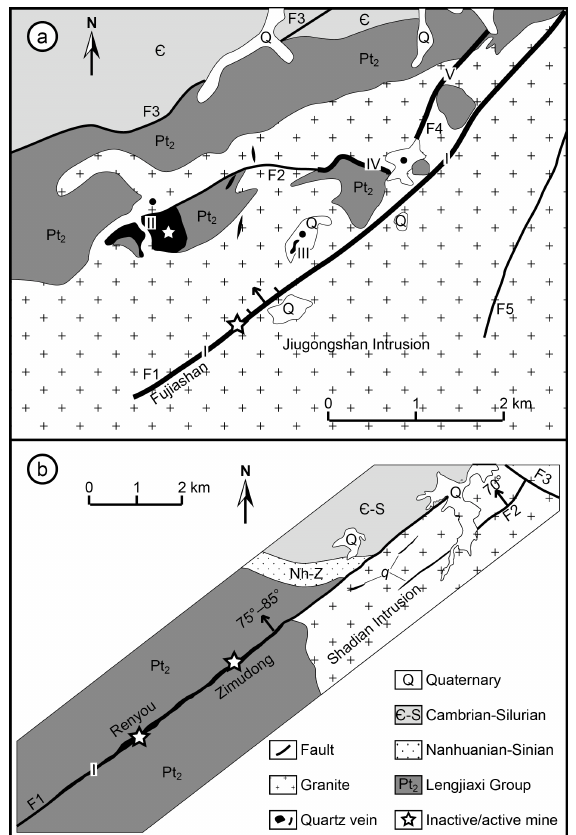
Figure 2. Geological sketch map of the Fujiashan ( a ) and Yipanqiu quartz deposits ( b ) showing the distribution of quartz veins and locations of local inactive/active mines. Modified from Zhou et al. [37] and Wang et al. [38].